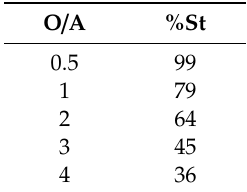
Table 4. Indium(III) stripping at various O / A relationships. O / A %St 0.5 99 1 79 2 64